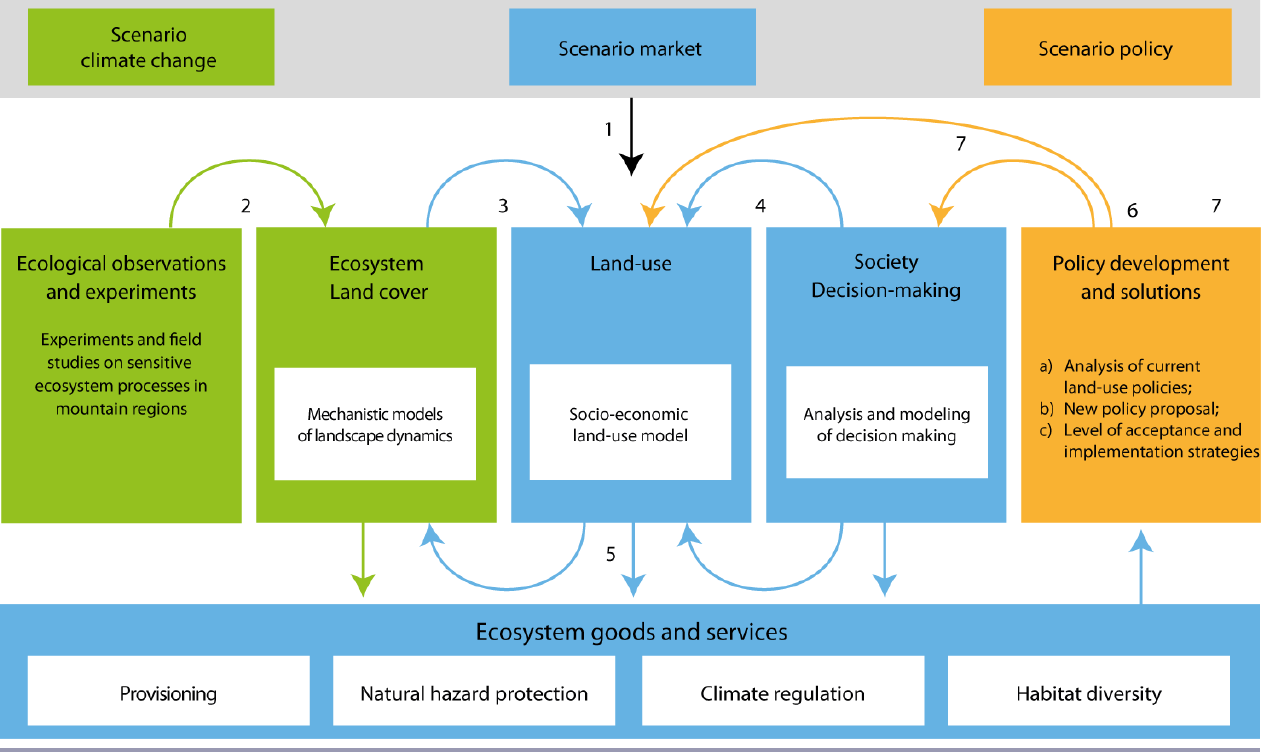
Fig. 2. Workflow and research methods in the Mountland project. Green boxes refer to ecological research, blue to socioeconomic research, and orange to policy assessments. Numbers indicate iterative procedure